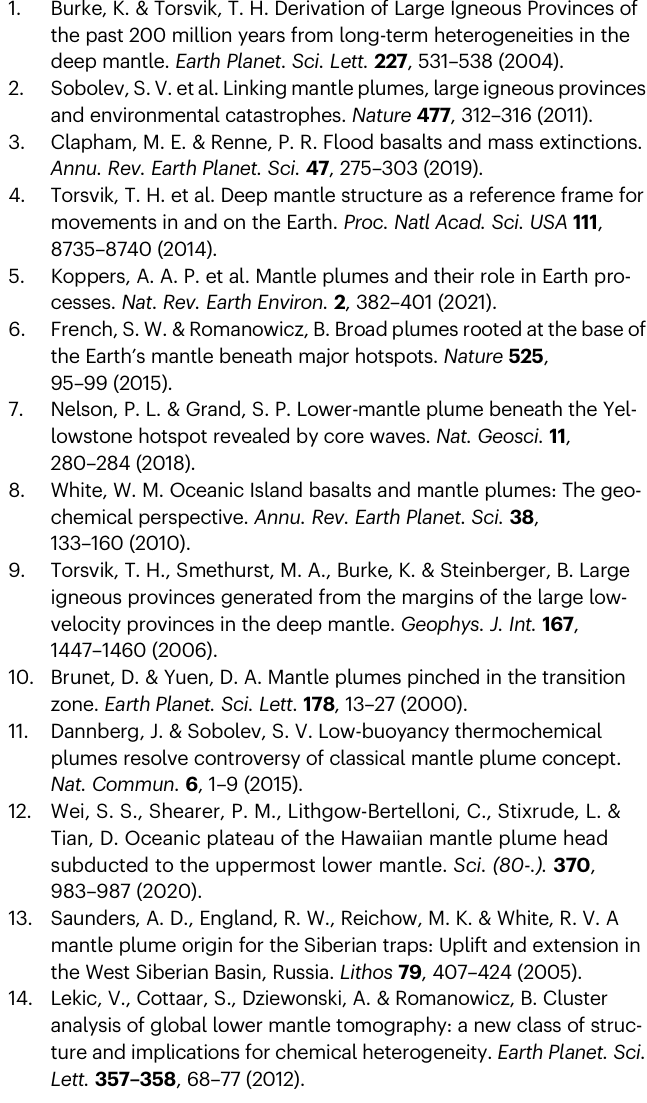
Supplementary Fig. 9a, b were all created using Generic Mapping Tools (GMT) 65